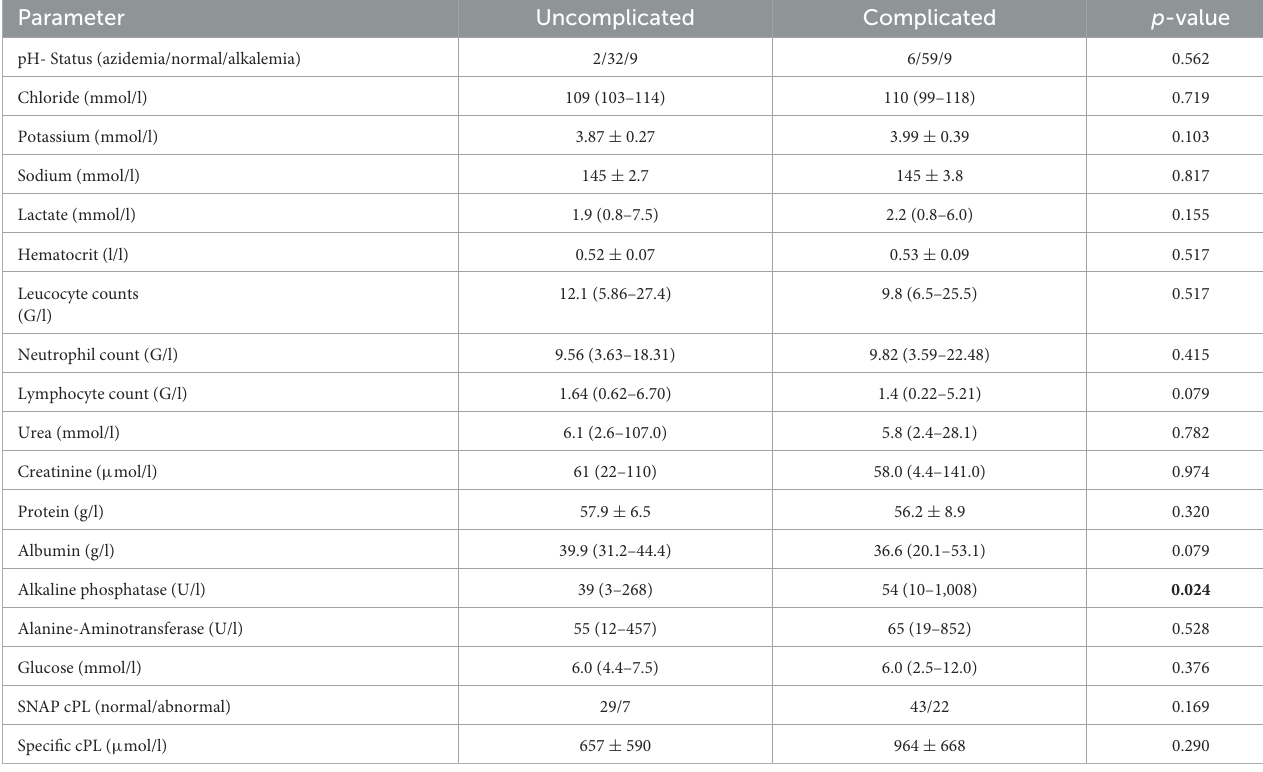
TABLE 5 Comparison of the results of venous blood gas and hematologic and biochemistry profile of 34 dogs with uncomplicated vomiting and 65 dogs with complicated vomiting. Parameter